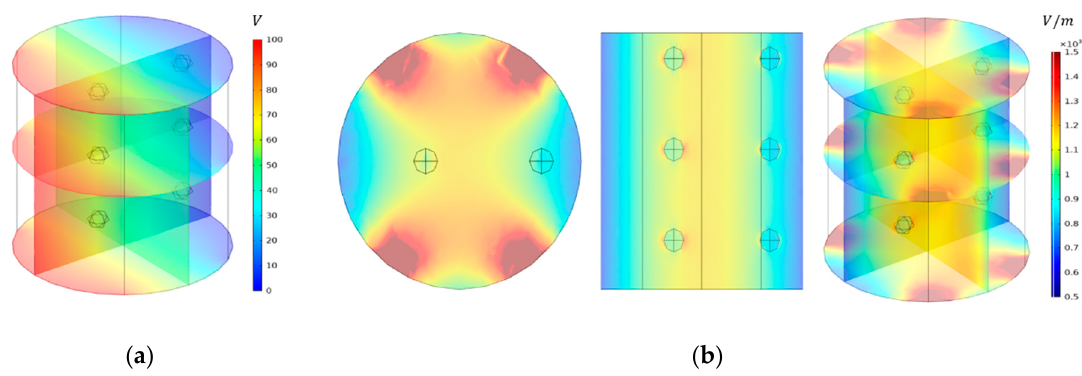
Figure 8. Simulated ( a ) electric potential and ( b ) electric field distributions .